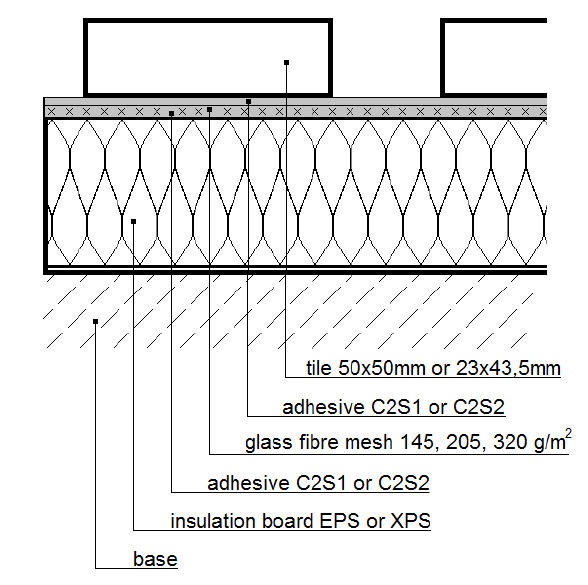
Figure 5: Cross-sections of the lightweight floor stand with insula- tion boards EPS and XPS with ceramic tile floor, in order to research of detachment and shear forces in two adhesives C2S1 & C2S2 and three fibreglass meshes